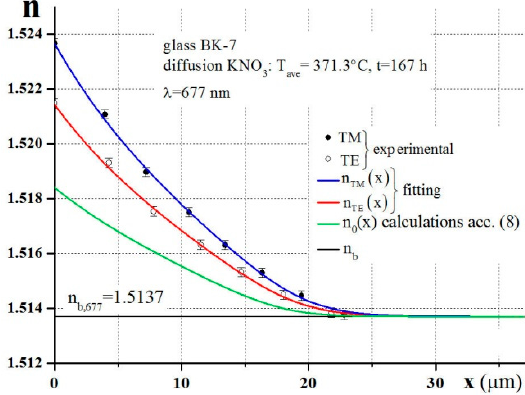
Figure 4. An example of profile determination n 0 ( x ) according to (8).